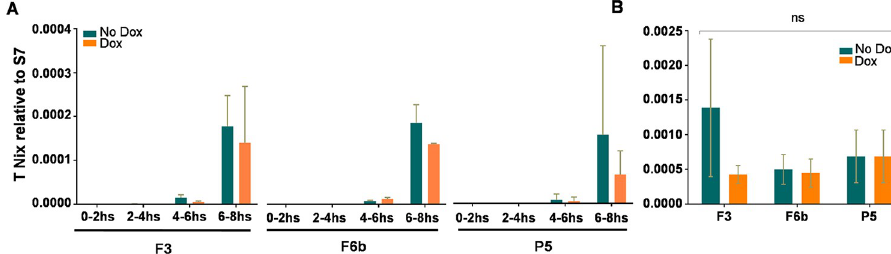
Fig 9. Impact of doxycycline on transgenic Nix expression. Quantification of accumulated transgenic Nix transcript treated and non-treated with 50 μ g/ml of Doxycycline from embryos collected 0-2h, 2-4h, 4-6h, 6-8hs after being laid from F3, F6b, and P5. ( A ) Transgenic lines and ( B ) Adult female mosquitoes. Columns represent the mean values and bars the standard deviation ( A-B ) of at least two independent experiments containing at least 50 embryos each ( A ) and 3 independent experiments ( B ). Multiple t test was used to determine the statistical significance ( B ); ns: P > 0.05; ��� : P < 0.0001.